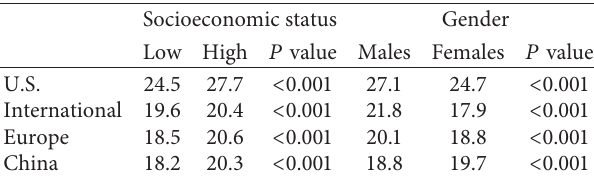
P value represents differences among